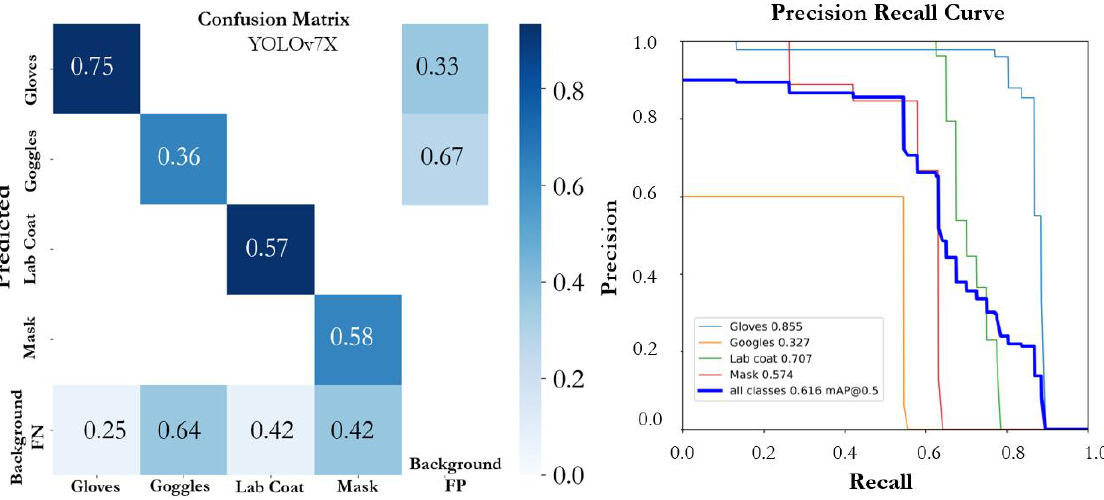
Figure 14. Confusion matrix and PR curve of the YOLOv7X model.